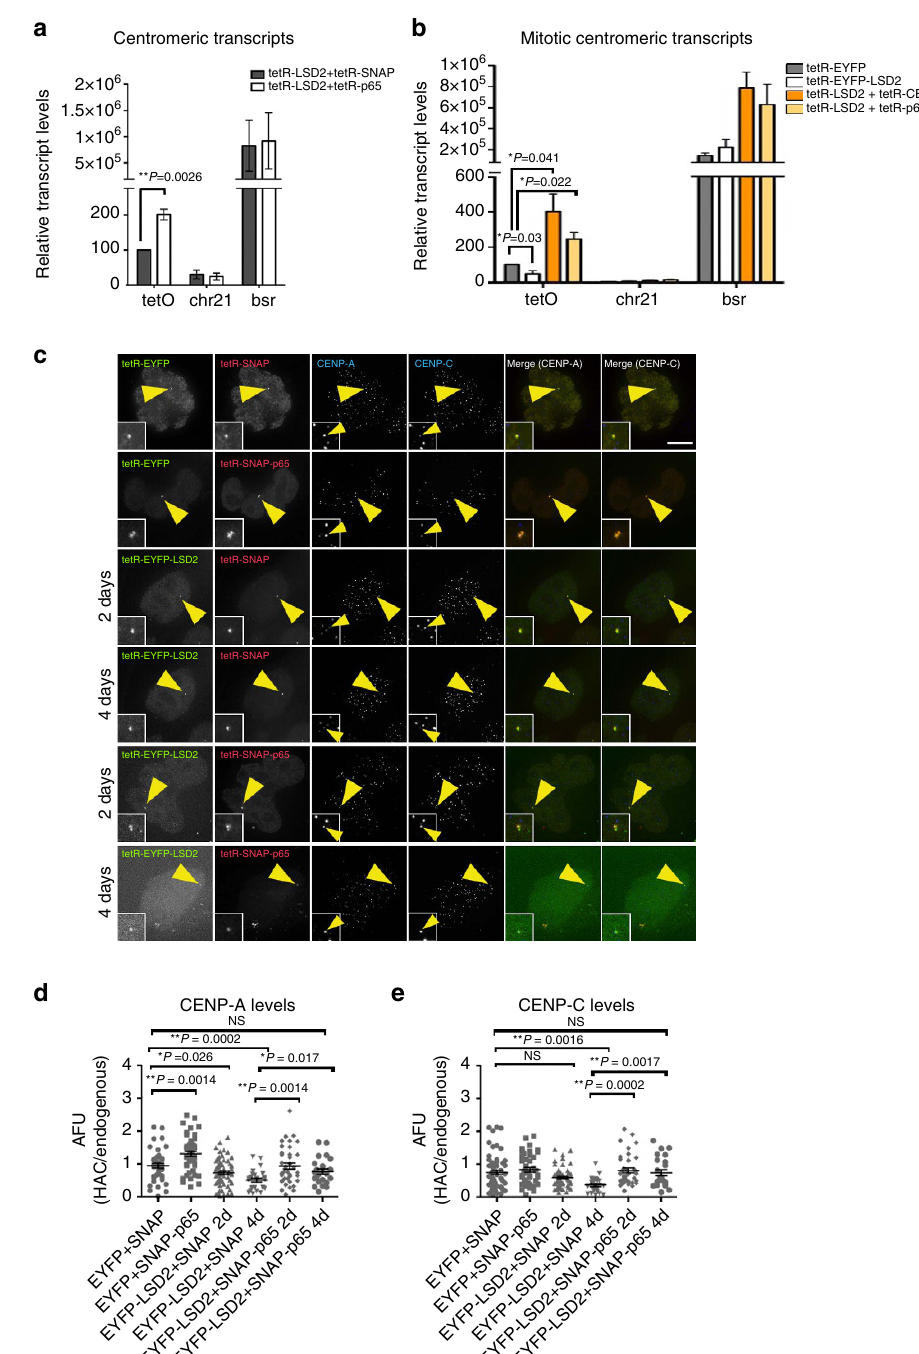
Figure 6 | LSD2 effects on the alphoid tetO HAC kinetochore are recovered by tethering a transcriptional activator that hyperacetylates histone H3K9. ( a ) RT-PCR analyses of 1C7 cells transfected with tetR-EYFP-LSD2 WT with either tetR-SNAP (grey bars) or tetR-SNAP-p65 (white bars). Expression levels of the alphoid tetO array (tetO), chromosome 21 centromere (chr21) and blasticidin resistance gene ( bsr ) were normalized to those of b -actin. Data represent the mean and s.e.m. of three independent experiments. ( b ) RT-PCR analysis of centromeric transcripts in 1C7 cells after mitotic shake-off and expressing tetR-EYFP (grey bars), tetR-EYFP-LSD2 WT together with either tetR-mCherry (white bars), tetR-mCherry-CENP-28 (orange bars) or tetR- SNAP-p65 (yellow bars). tetO (alphoid tetO array), chr21 (centromere of chromosome 21) and bsr . Data represent the mean and s.e.m. of three independent experiments. ( c ) Immunofluorescence images of 1C7 cells expressing the indicated tetR-fusion proteins at the indicated time points and staining for CENP- A and CENP-C. Merged images represent the overlay of EYFP and TMR-Star signals with CENP-A (panel 5) or CENP-C (panel 6). Quantification of fluorescence signals of HAC-associated CENP-A ( d ) and CENP-C ( e ) staining in individual cells transfected with the indicated tetR-fusion constructs. Values for the HAC-associated CENPs signals were normalized for the mean of the CENPs signals of endogenous centromeres. Solid bars indicate the medians and error bars represent the s.e.m. N ¼ two independent experiments per time point and staining. Asterisks indicate significant differences (* P o 0.05; ** P o 0.01; Mann–Whitney’s test). Scale bar, 10 m m.